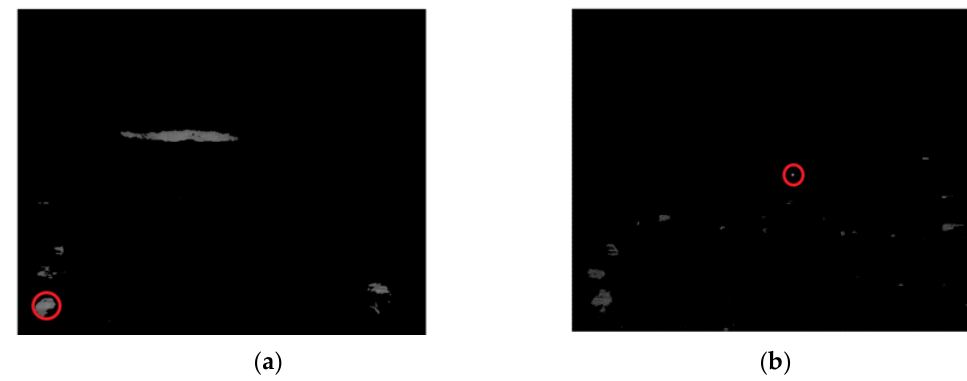
Figure 6. Results using nearest neighbors to associate targets in different frames. ( a ) Without using rules; ( b ) With rules.